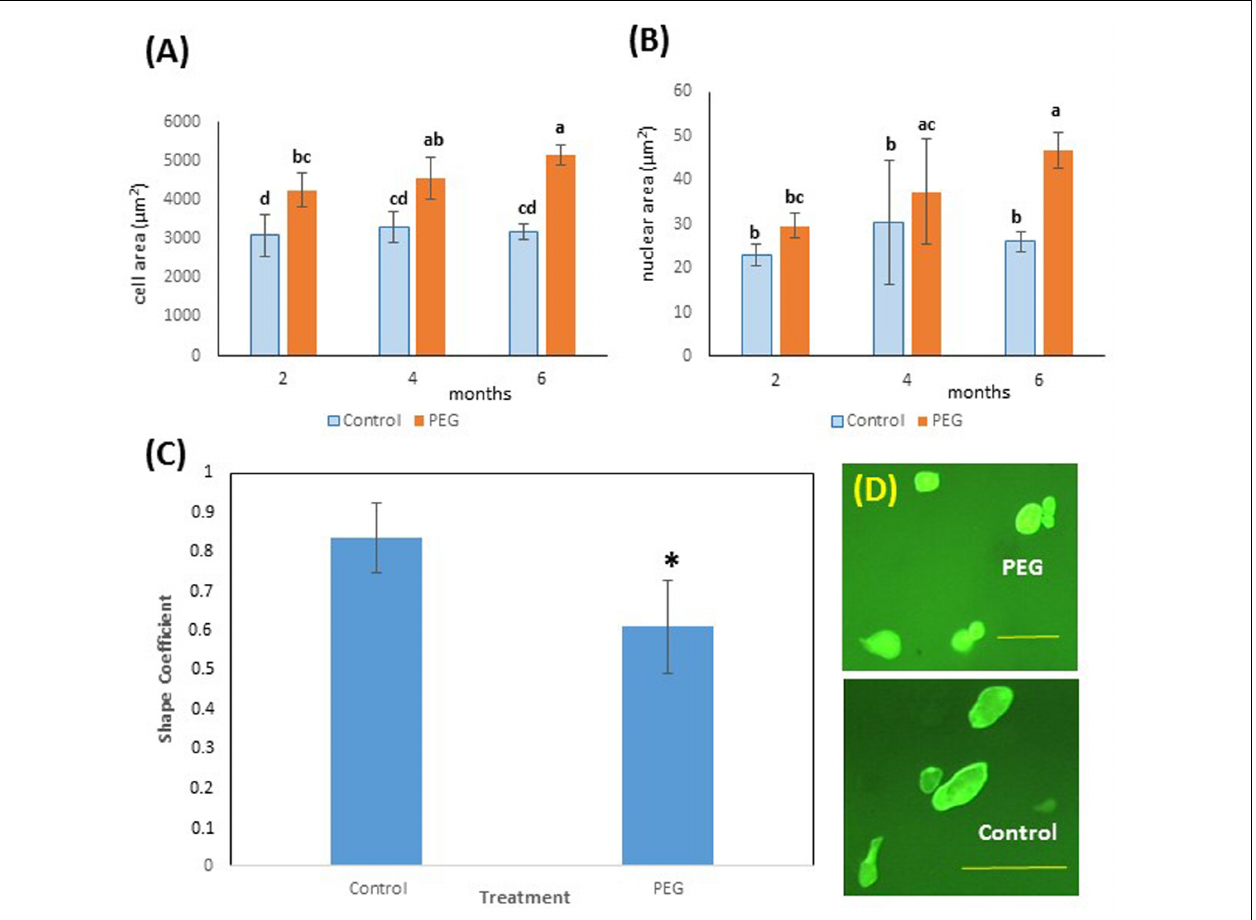
FIGURE 4 | Effects of PEG6000 on cell morphology. (A) Cell and (B) nuclear size ( µ m 2 ) at different time points during in vitro selection for PEG6000 (10%) resistance. Data are the means ± SD from n = 9 replicates at 2 and 4 months of culture and n = 22 measurements at 6 months of culture. Bars with different letters were significantly different (Kruskal–Wallis followed by Dunn’s test) at different time points across treatments ( P < 0.05). See Supplementary File S3 for data and statistical analyses. (C) Shape coefficient (SC) of cells from control (blue) and PEG-grown (orange) calli ( n = 22) at 6 months of mean ± SD ( ∗ P < 0.05, Welch Two Sample t -test). See Supplementary File S4 for data and statistical analyses. (D) Images of cells from PEG and control cultures at 6 months of culture (scale bars PEG = 100 µ m, Control 200 µ